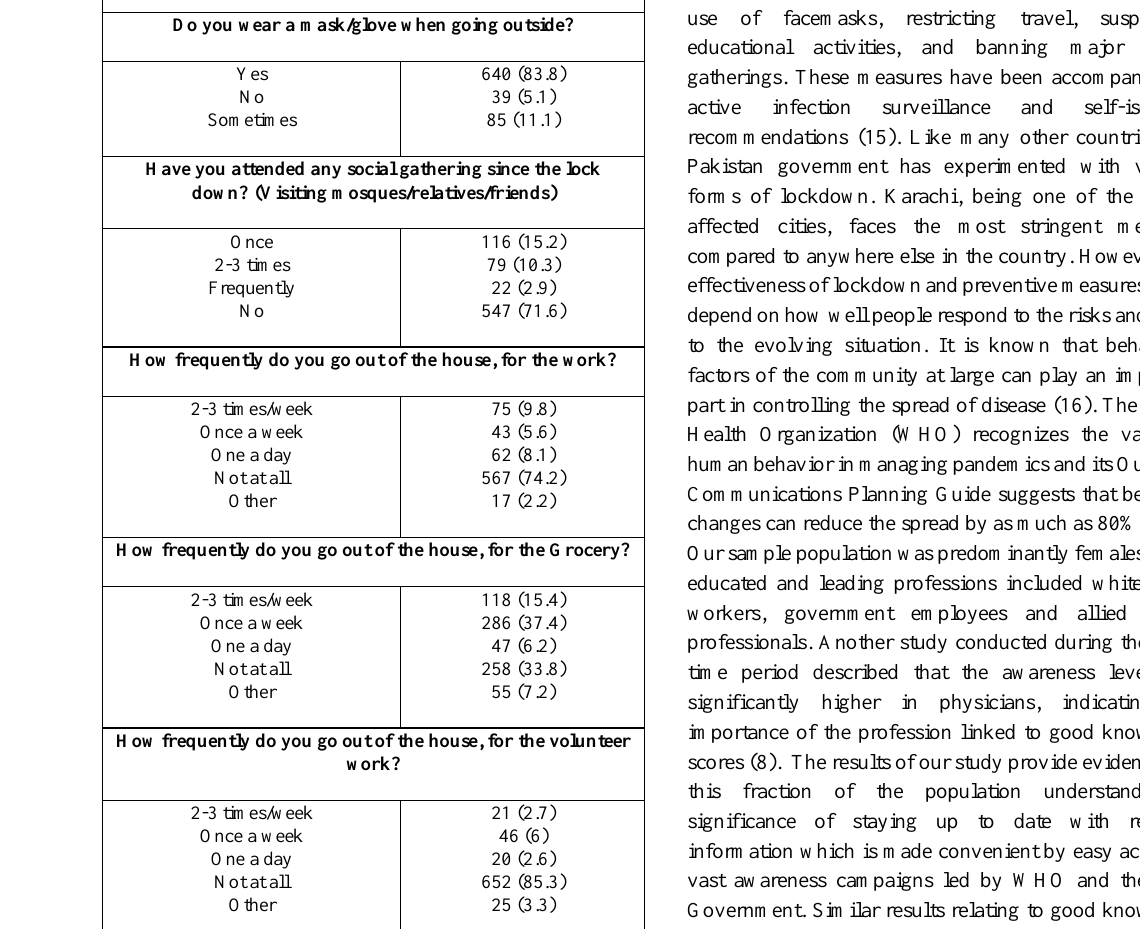
Table 3: Practices Regarding